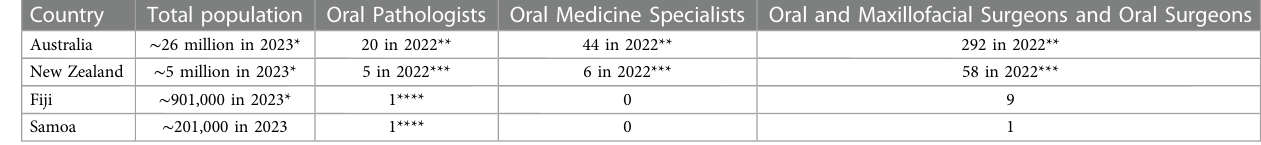
TABLE 2 Number of specialists managing OPMD in Oceania.